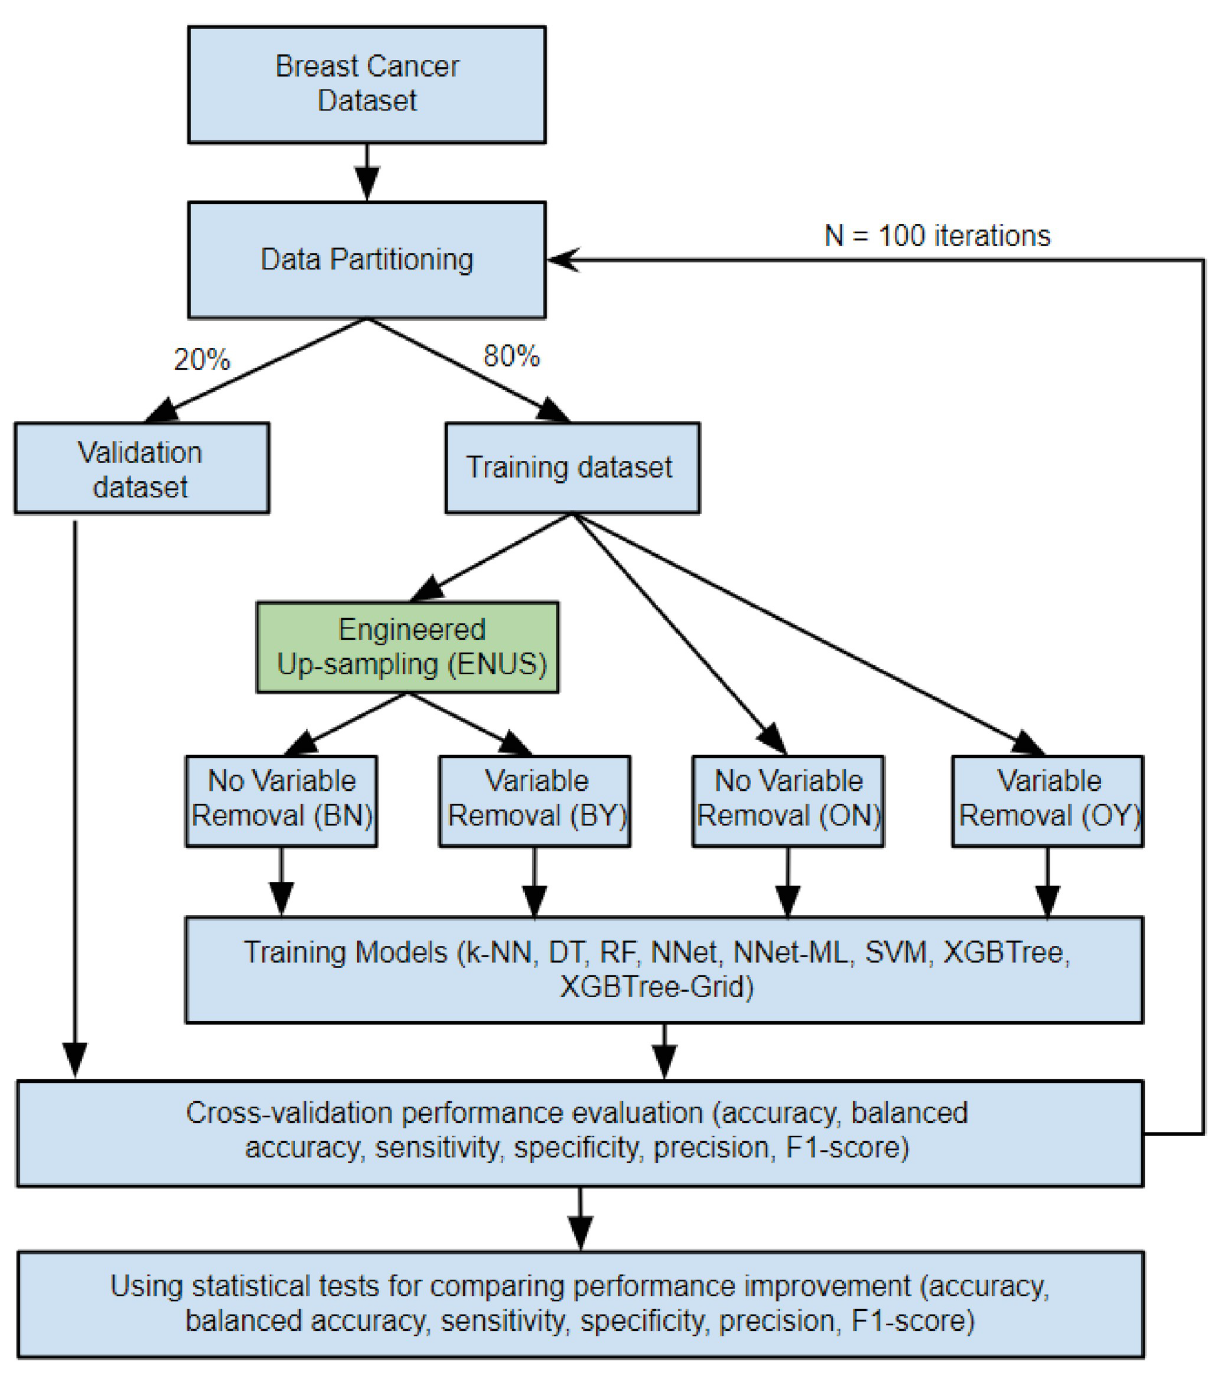
Fig 7. Experiment setup